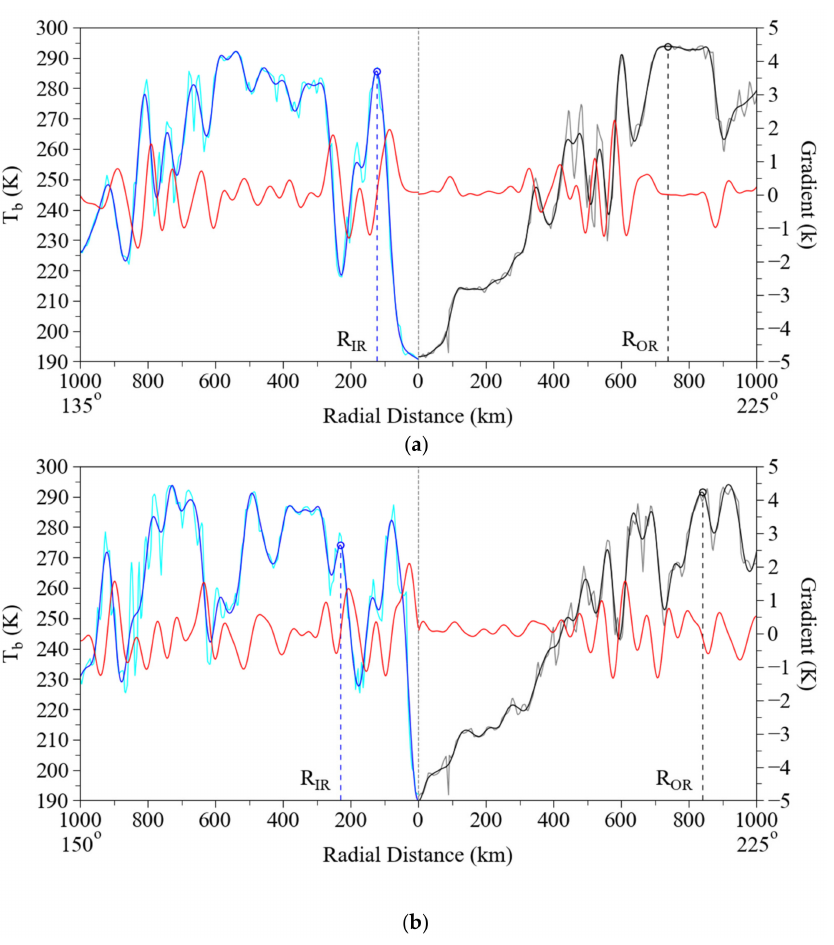
Figure 13. ( a ) Same as Figure 4c or Figure 4d except for Jose at about 1000 UTC September, 11 2017.